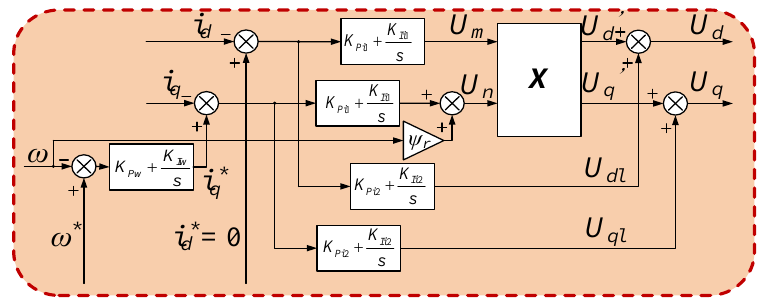
Figure 7. Dual current loops control.